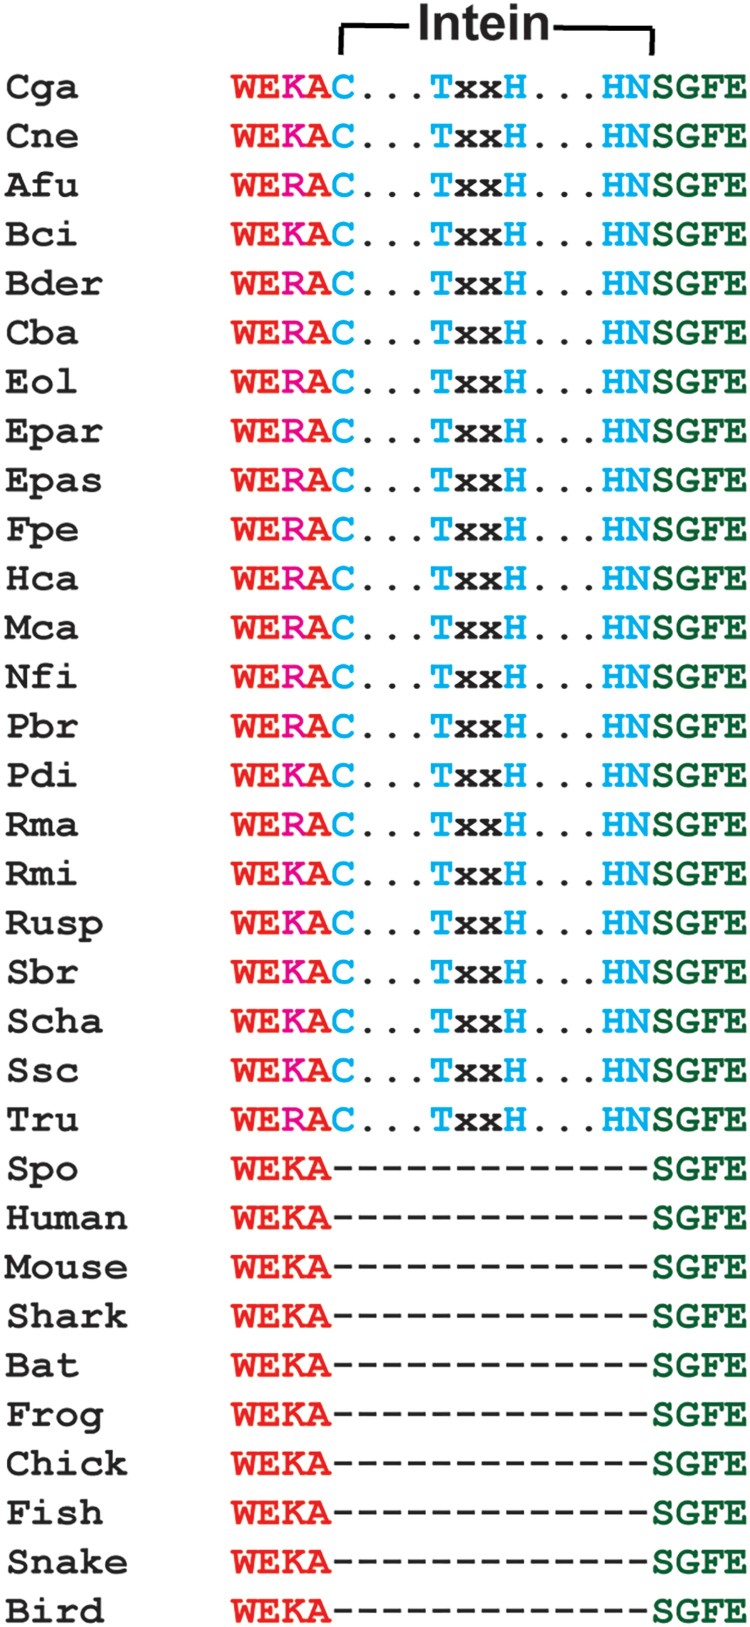
Alignment of sequences of intein-containing Prp8s of representative fungi known to cause human diseases with those of representative intein-free Prp8s at the intein insertion site. Conserved intein elements are in cyan. Abbreviations of organisms not defined in main text: Blastomyces dermatitidis (Bder), Botrytis cinerea (Bci), Cladophialophora bantiana (Cba), Emergomyces pasteurianus (Epas), Emmonsia parva (Epar), Exophiala oligosperma (Eol), Fonsecaea pedrosoi (Fpe), Histoplasma capsulatum (Hca), Microsporum canis (Mca), Neosartorya fischeri (Nfi), Paracoccidioides brasiliensis (Pbr), Penicillium digitatum (Pdi), Rhinocladiella mackenziei (Rma), Rhizopus microsporus (Rmi), Sporothrix brasiliensis (Sbr), Sporothrix schenckii (Ssc), Stachybotrys chartarum (Scha), Trichophyton rubrum (Tru), and chicken (Chick).